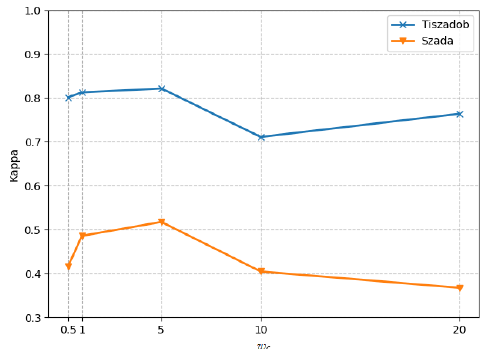
Figure 19. The effects of parameter w c on the accuracy of